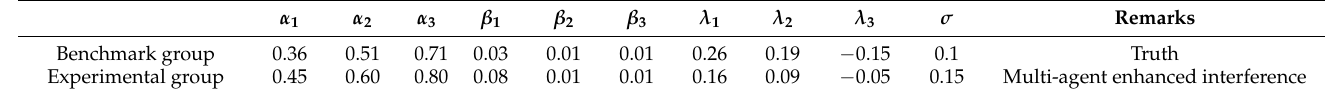
Table 8. Parameter setting. Figure 9. Impacts on public opinion evolution under different constraints of parties.